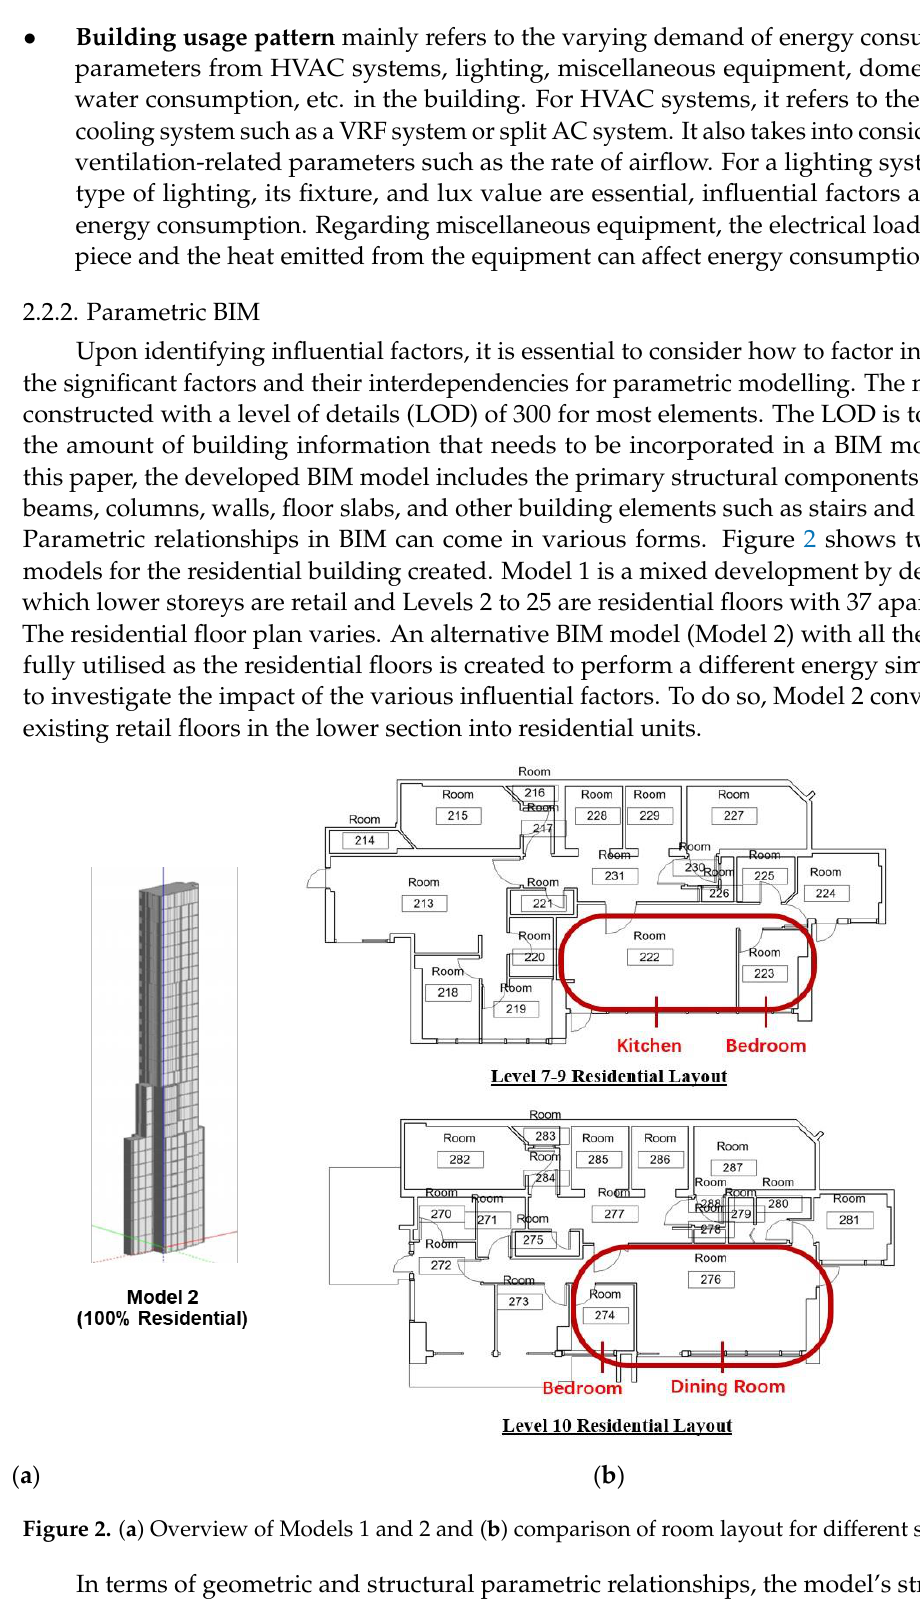
Figure 3. Room bounding setting for a wall (left) and limit offset setting for a room (right). To ensure the retainment of BIM models for lifecycle energy prediction, two methods are used to facilitate the interoperable information exchange between BIM and energy simulation software and to aid in resolving the issues brought by the incompatibility. This study involves exporting the BIM model through green building XML (gbXML), an indus- try standard for storing and exchanging building information. The rooms and their de- fined elements, which comprise gbXML data, are exported from BIM.